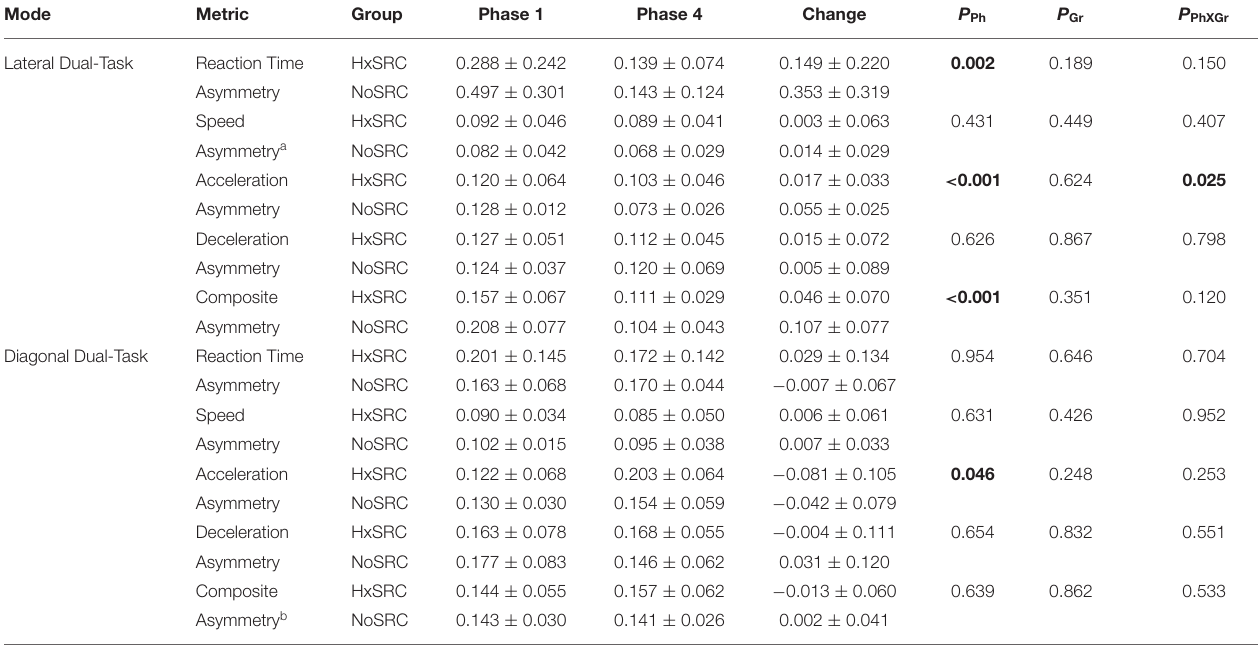
TABLE 8 | Group mean ± standard deviation for Dual-Task asymmetry.